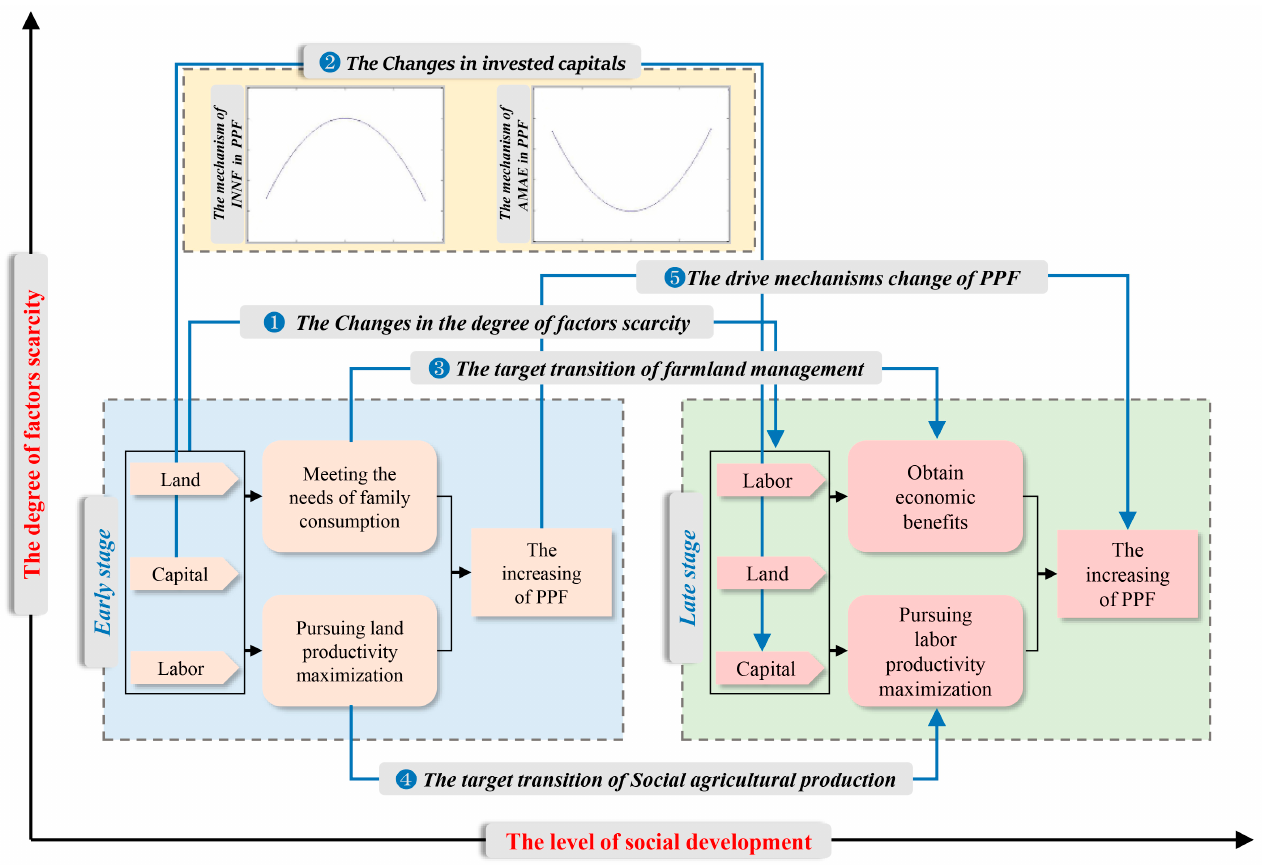
Figure 5. The driving mechanism of the area proportion of paddy fields in Hubei province between 1990 and 2016.